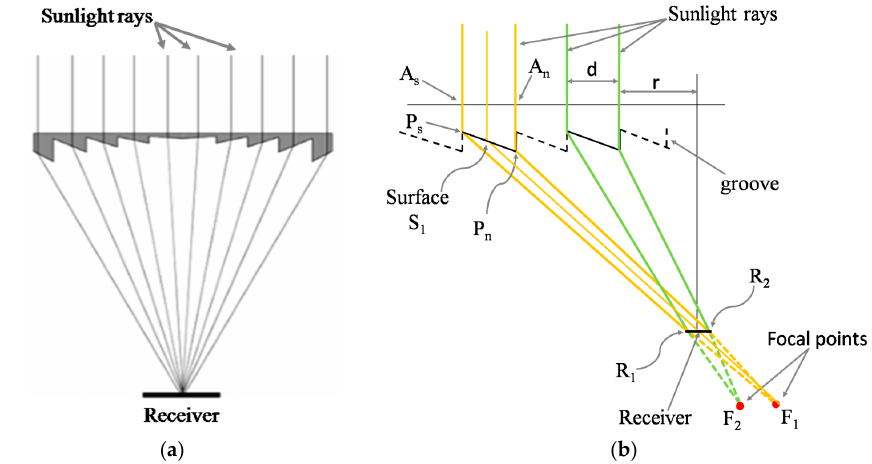
Figure 3. The linear Fresnel lenses with ( a ) the linear Fresnel lens focuses the sunlight on dimension (cid:1841)(cid:1876) (cid:4652)(cid:4652)(cid:4652)(cid:4652)(cid:1318) ; ( b ) the linear Fresnel lens focuses the sunlight on dimension (cid:1841)(cid:1877)(cid:4652)(cid:4652)(cid:4652)(cid:4652)(cid:4652)(cid:1318) .